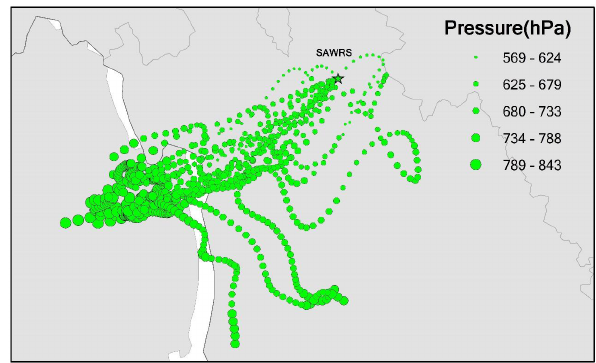
Figure 10. The back trajectories of air mass from 17 to 22 Septem- ber. The trajectory points reaching ground level are not shown in the figure.